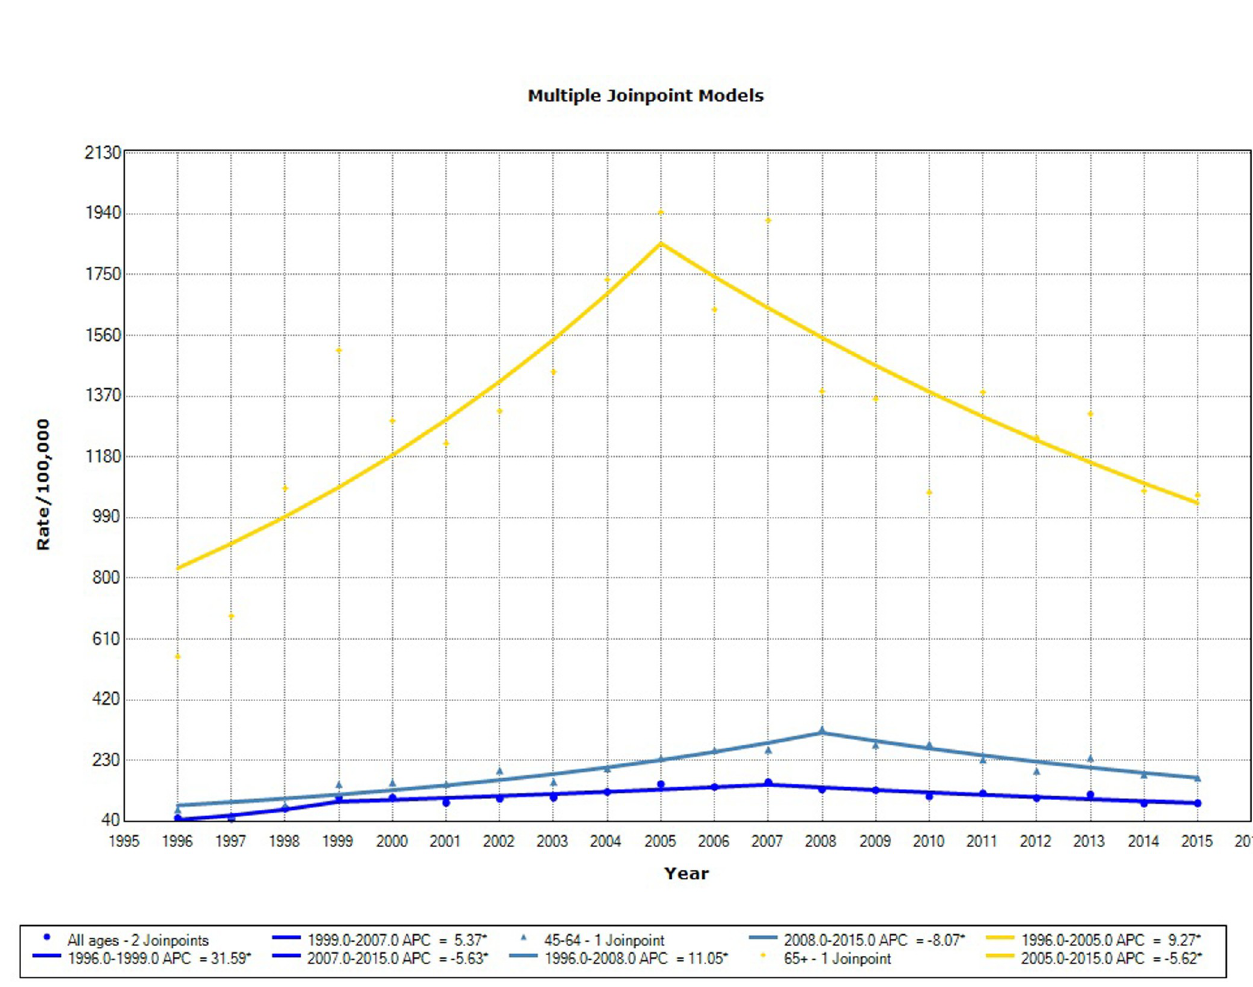
Fig 1. Incidence trends for prostate cancer in the cancer registry area,